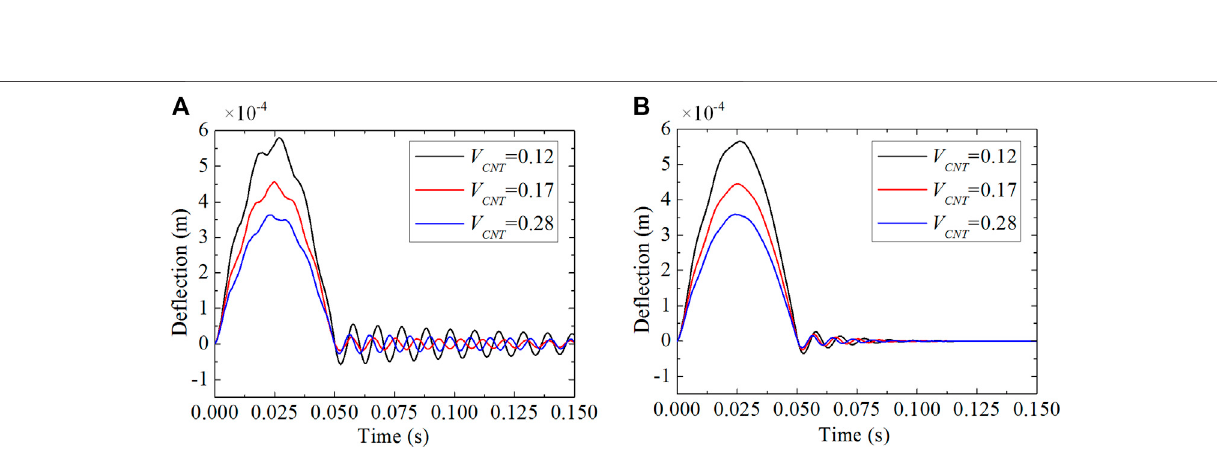
for V CNT (cid:2) 0 . 17, and η PMMA are 3 . 52Gpa, 0.34, and 1150kg/m 3 , respectively. The (cid:2) ef fi ciency parameters of different CNT volume fractions are η (Kiani, 2016b). In addition, η 1 (cid:2) 1 . 022 for V (cid:2) 0 . 12, η (cid:2) 0 . 142 and η (cid:2) 1 . 626 0 . 137 and η from molecular dynamics (MD) simulations (Shen and Zhang, CNT 2 1 2